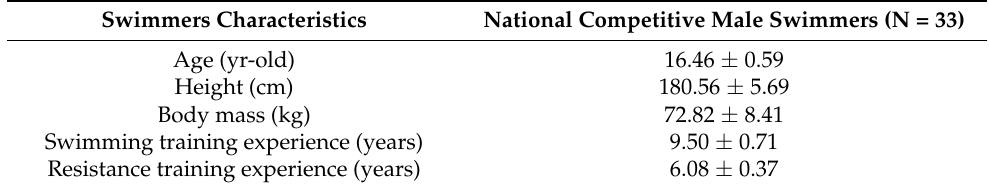
Table 1. Physical experience and anthropometric characteristics of the swimmers (mean ± SD).